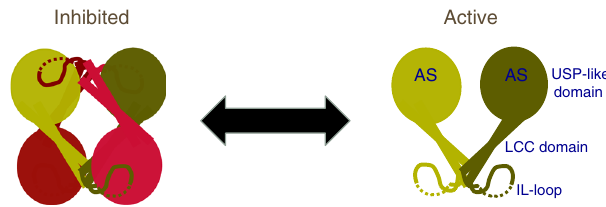
Fig. 7 USP25 transition between dimer and tetramer. Each cartoon color represents a USP25 monomer. The scheme depicts a potential switch between tetramer and dimer assemblies of USP25, or between inhibited and active forms of USP25. AS active